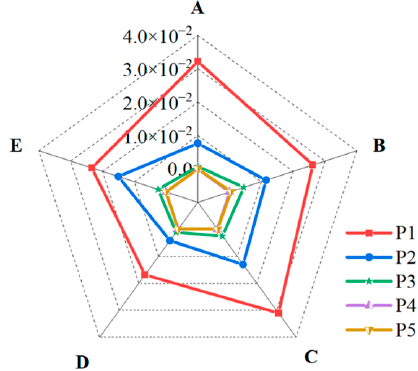
Figure 10. Equivalent plastic strain map of the forging after cold expansion.